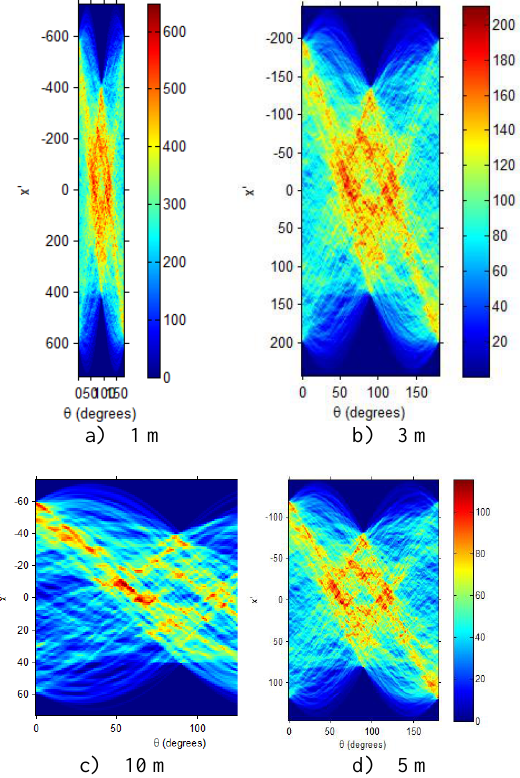
Figure 6. Radon images of the TA1 sample with different geometric